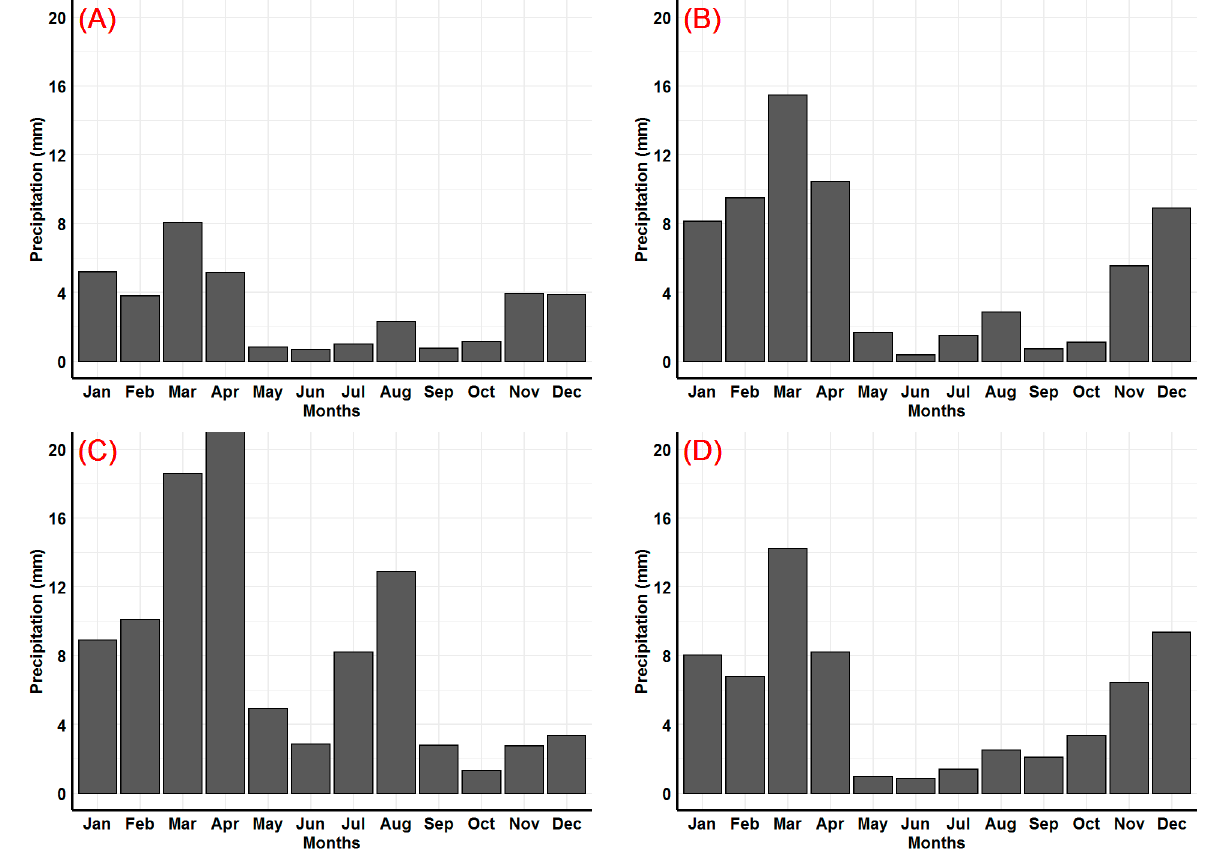
Figure 5. Distribution of monthly average rainfall for ( A ) CMORPH, ( B ) IMERG, ( C ) PERSIANN, and ( D ) rain gauges.